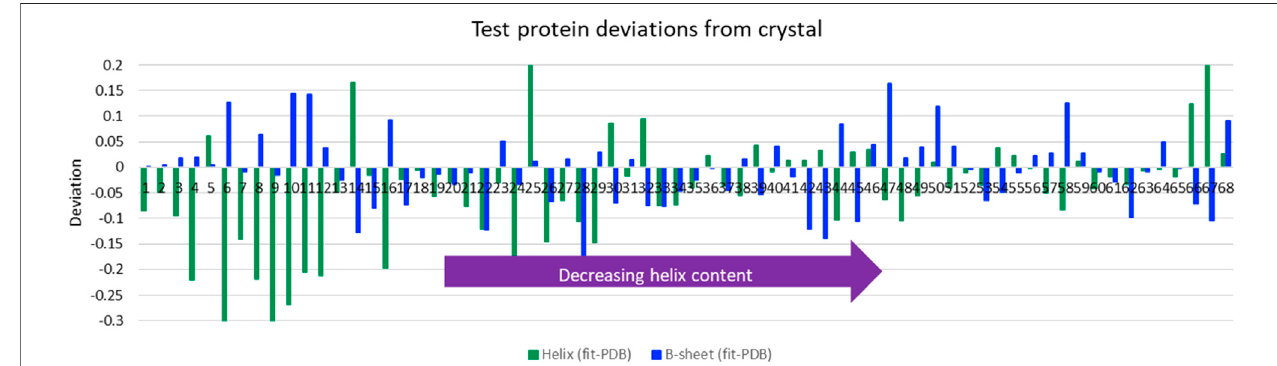
FIGURE 2 | Deviations of predictions from PDB structures for average helix ( α -helix + 3 10 -helix) and β -sheet for Amide I of 68 aqueous test proteins presented in order of decreasing helix content from left to right. Other category deviations are minus the sum of helix and β -sheet deviations.